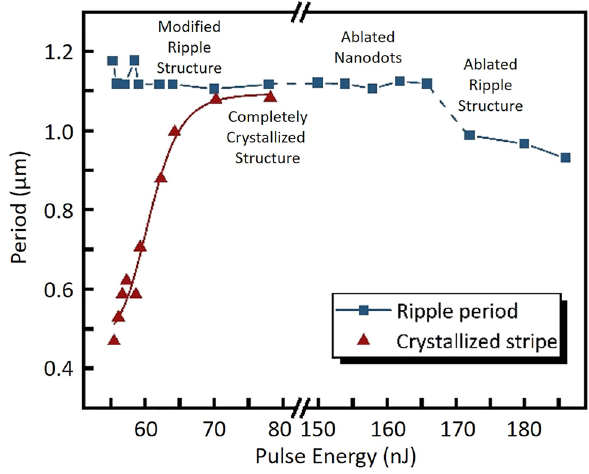
Figure 4: Parameters of the surface structures for different pulse